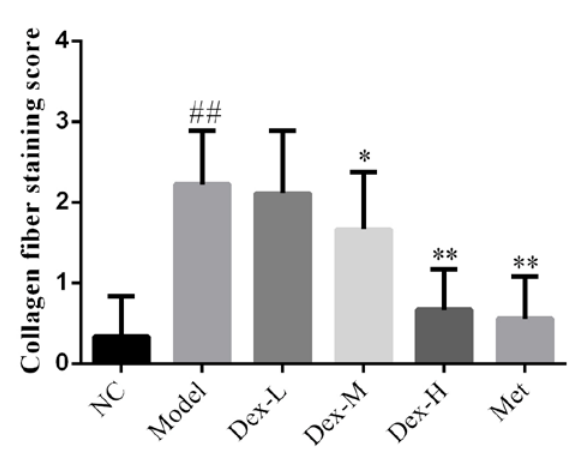
Figure 3: Comparison of Collagen Fiber Staining Rate in Kidney of Rats in Each Group NC: normal control group; Model: DN model group; Dex-L: Dex low- dose treated group; Dex-M: Dex medium-dose treated group; Dex-H: Dex high-dose treated group; Met: Metformin treated group ##: P<0.01, compared with NC group; *: P<0.05, **: P<0.01, compa- red with Model